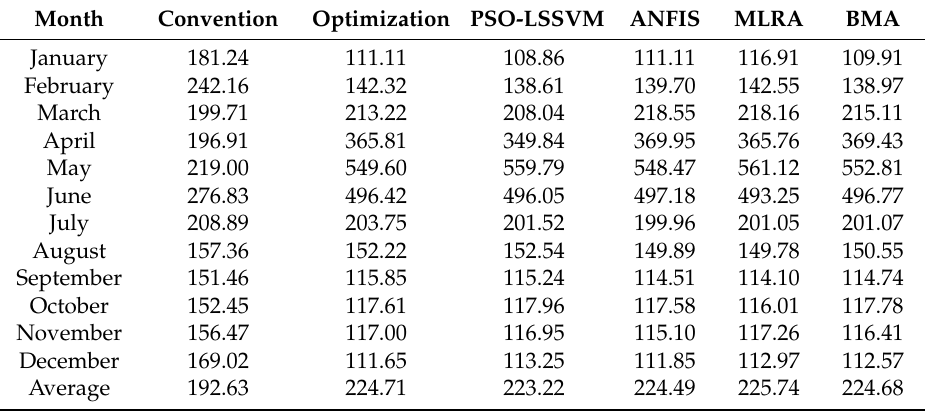
Figure 5. The hydropower reservoir operation results of the optimal/conventional operation from January 1962 to December 2007. Table 3. Average monthly power output of hydropower reservoir simulated using the optimal/conventional operation, PSO-LSSVM, ANFIS, MLRA, and BMA